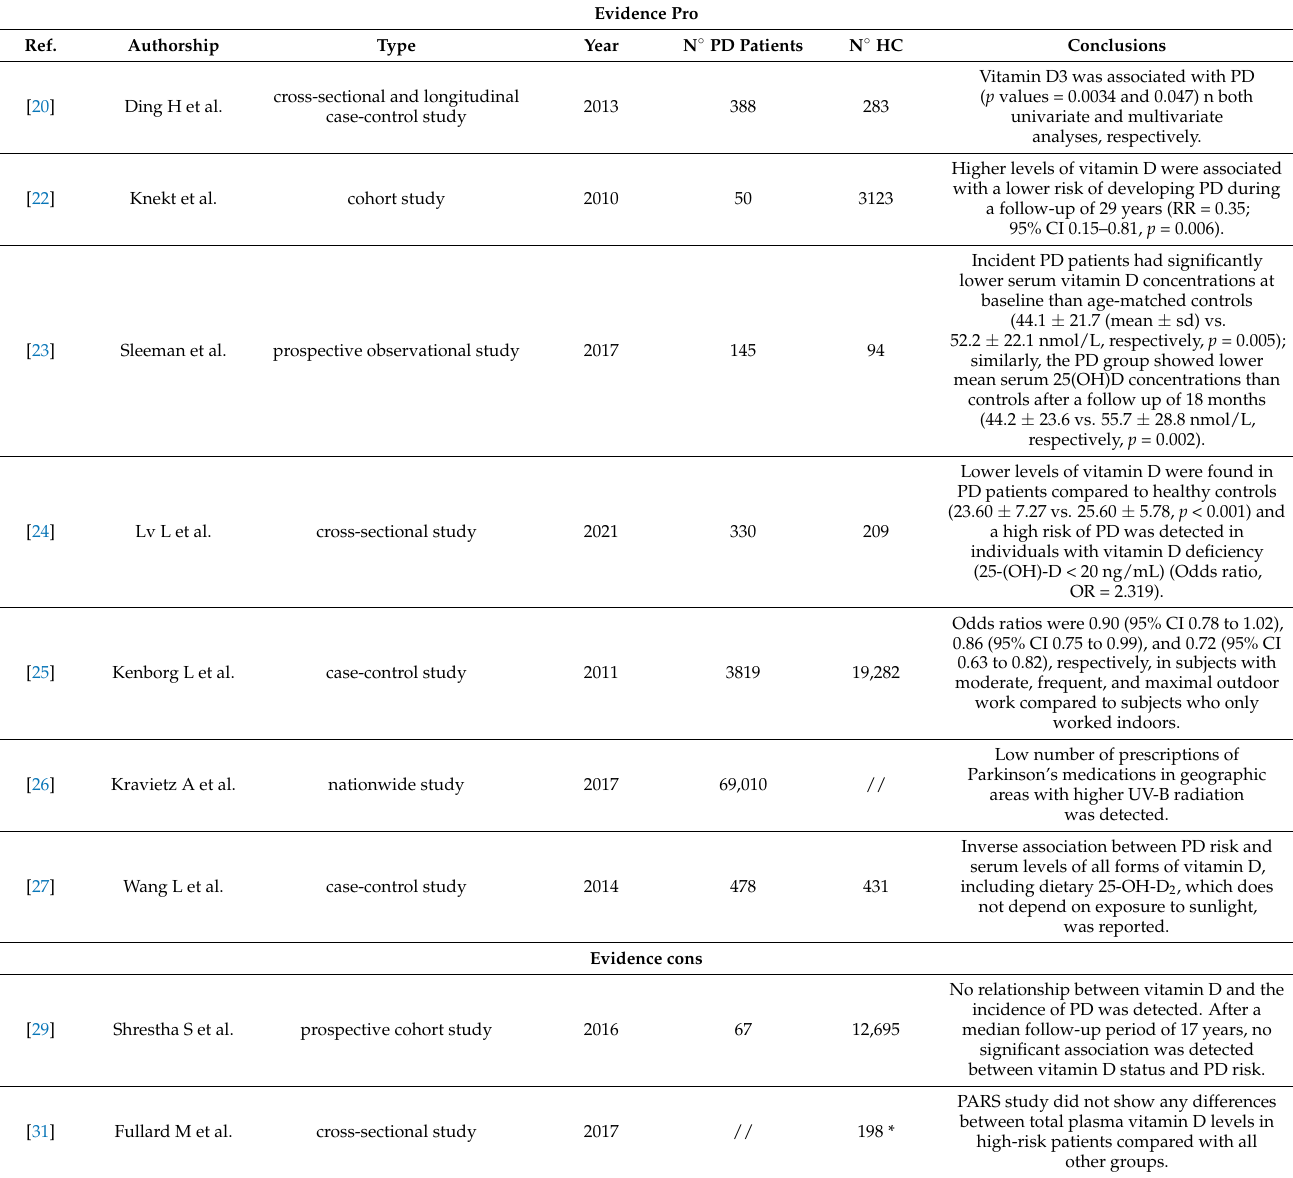
Table 2. Association of Vitamin D status with PD risk, pro and cons evidences. Legend of abbrevia- tions: PD (Parkinson’s Disease); HC (Healthy Controls). * Subjects from the Parkinson Associated Risk Syndrome (PARS) Study, a cohort of asymptomatic individuals, some of whom are at high risk for PD.